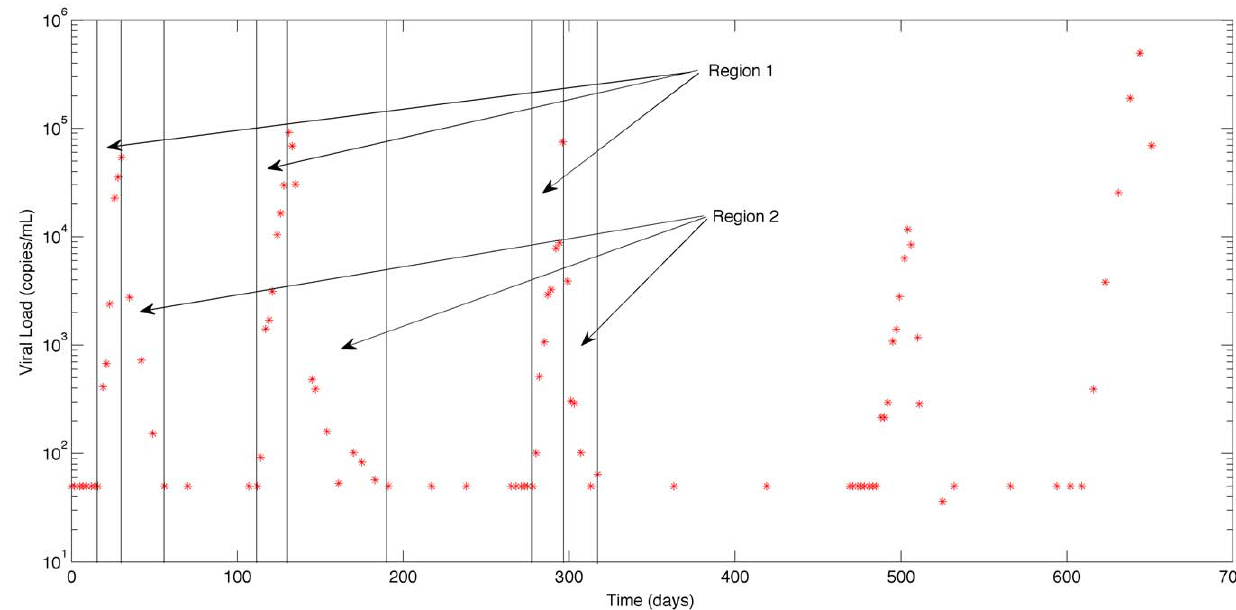
Figure 1. The viral load data for Patient 1.